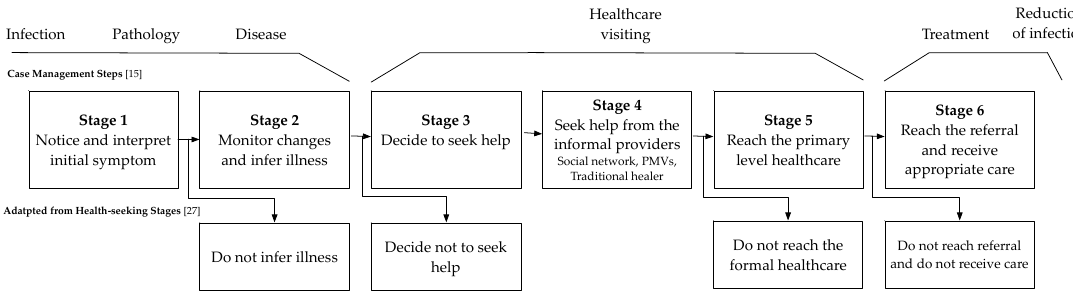
Figure 1. Adapted health ‐ seeking pathway with six stages based on [15] and [27].